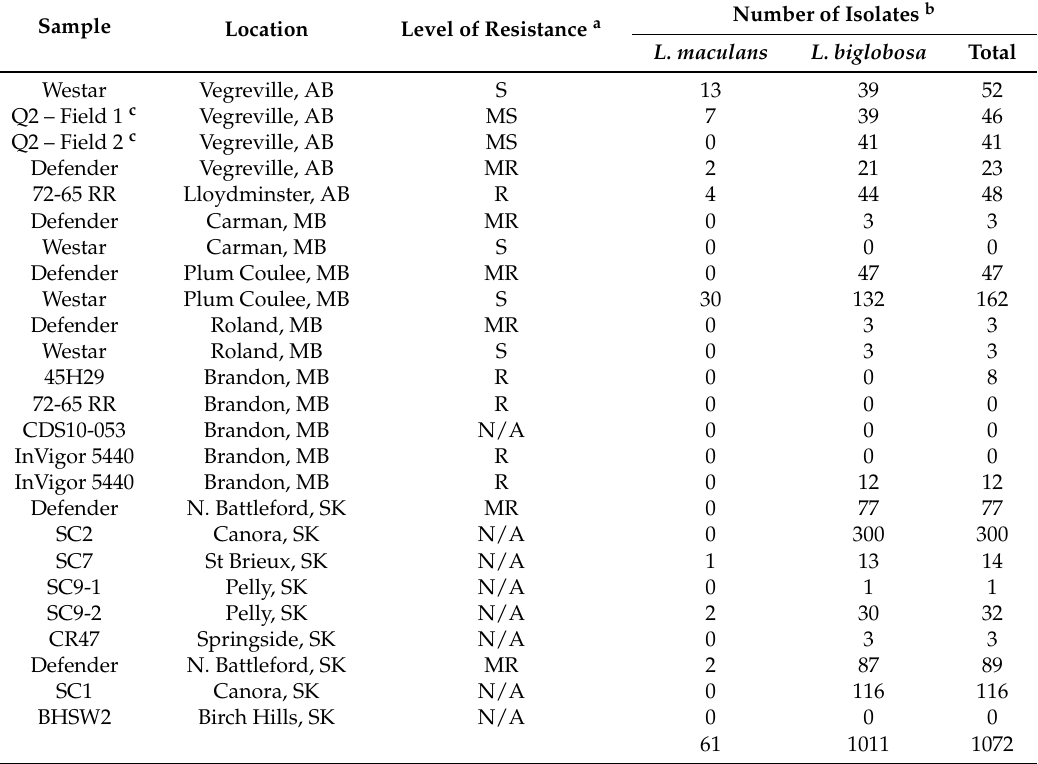
Table 1. Summary of Blackleg isolates recovered and identified from canola seed lots collected from co-op sites across Western Canada in 2011.